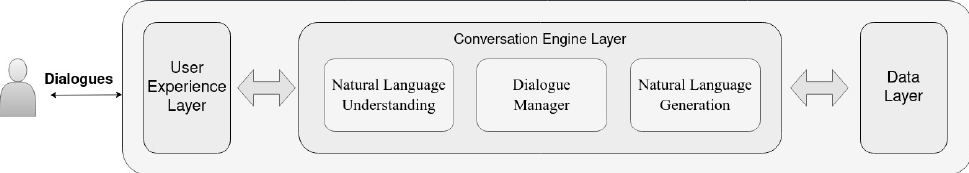
Figure 6. The process model of Dialogue